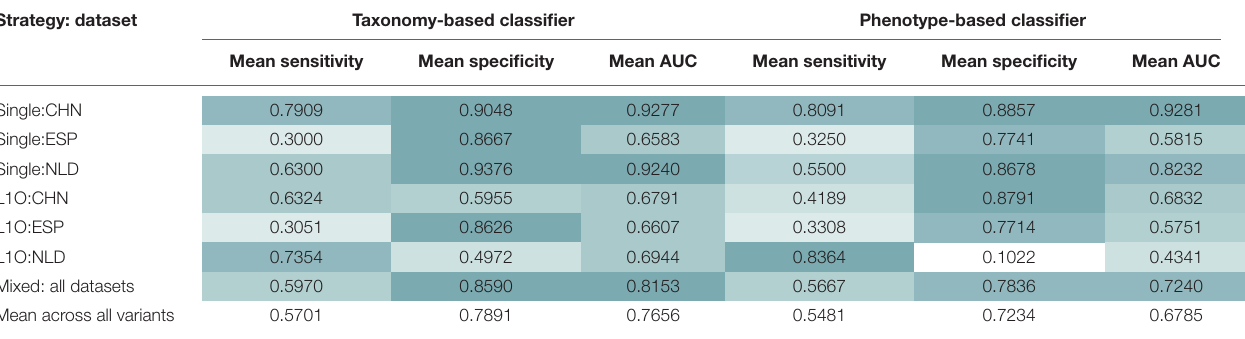
TABLE 5 | Mean performance characteristics of the taxonomy- and phenotype-based UC classifiers over 10 classification iterations. Strategy: dataset